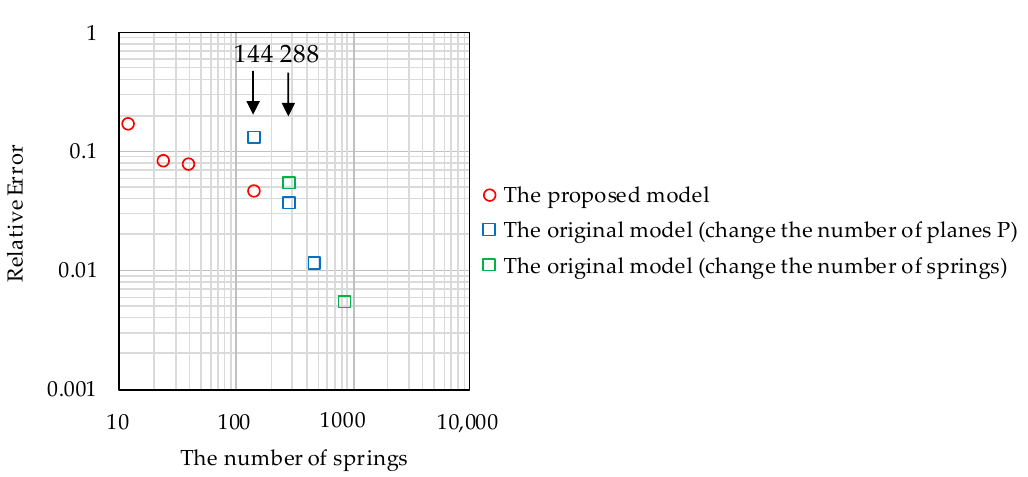
Figure 6. The relative error due to difference in the number of springs against cyclic simple shear loading by finite element total stress analysis method with a single solid element; when the load 𝜏 (cid:3053)(cid:3051) of 30 kPa was used.